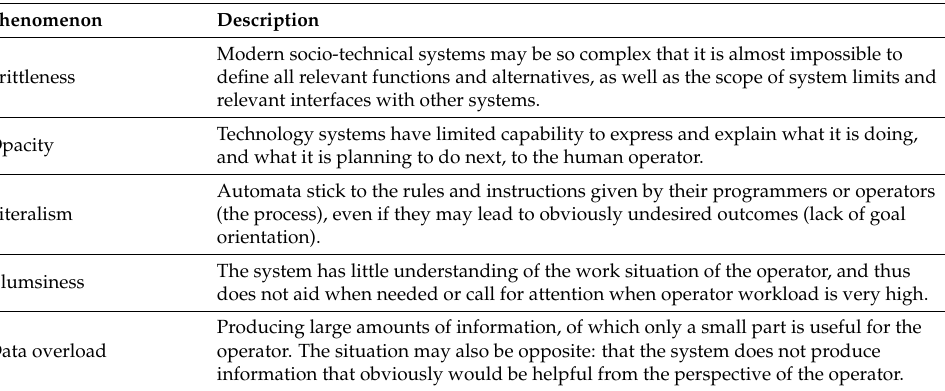
Table 3. Challenges in automation.